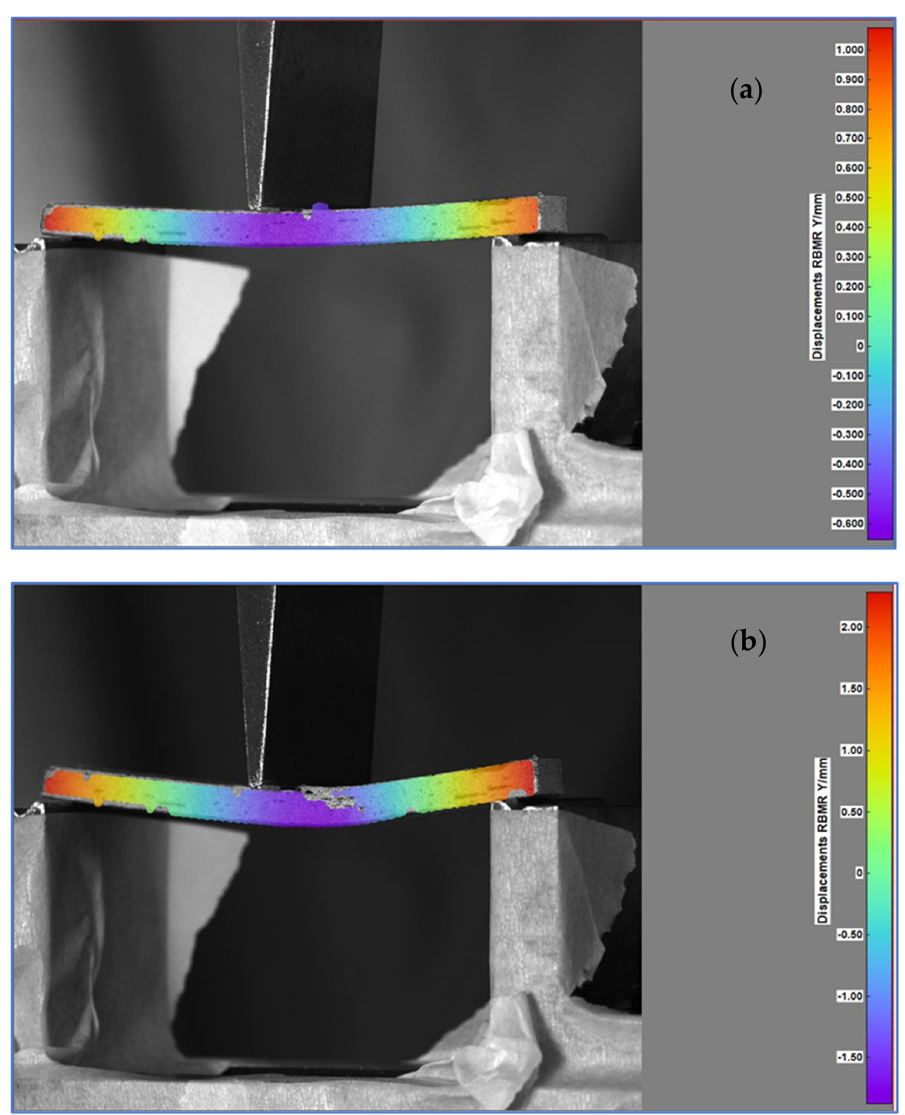
Figure 12. Specimen subjected to bending load, midway—Frame 600 ( a ) and near the end—Frame 1200 ( b ) of the test.